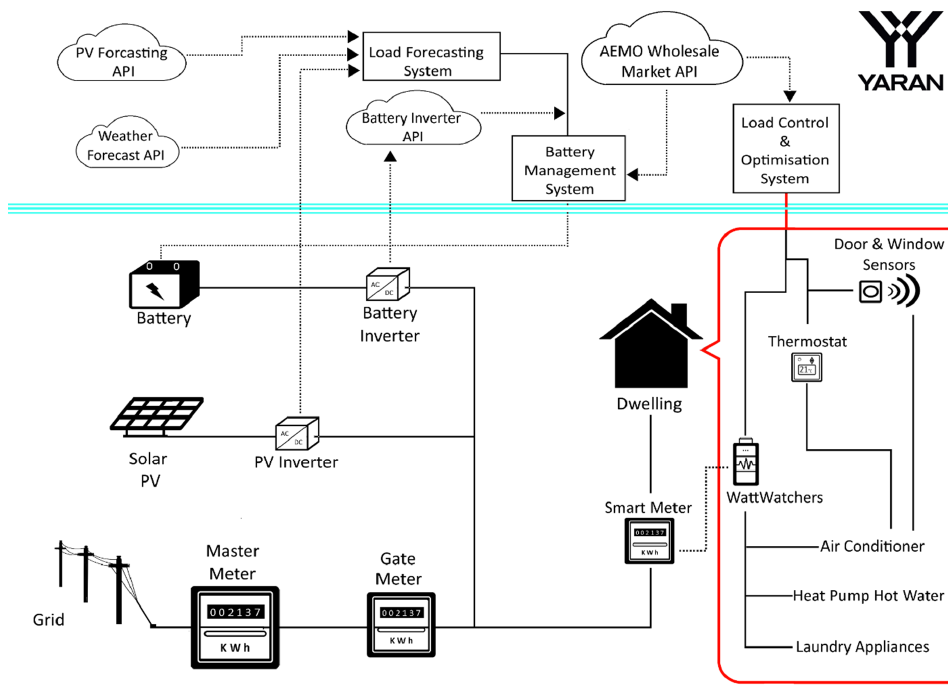
Figure 1. The proposed architecture of the virtual power plant (VPP) in Western Australia (WA).